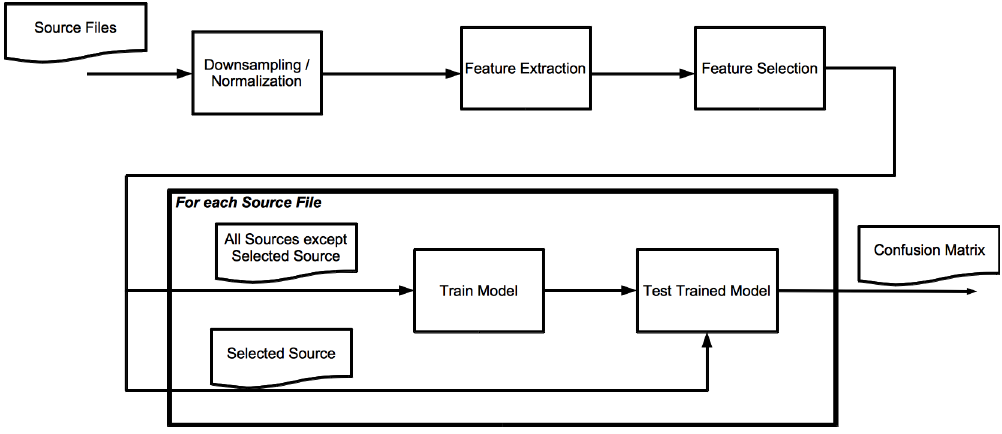
Figure 1. Classification